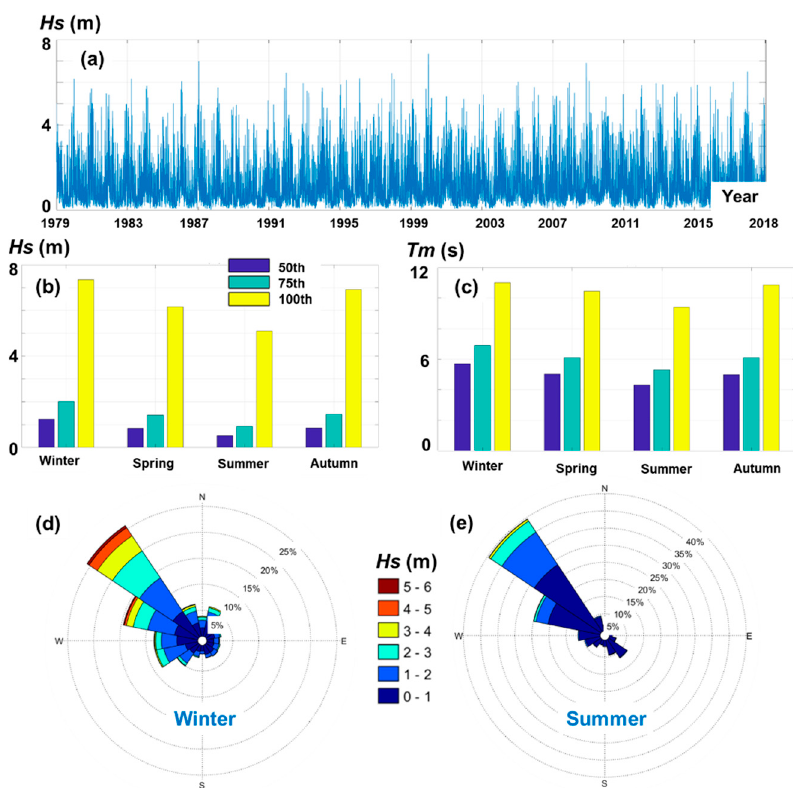
Figure 5. Wave conditions corresponding to the geographical position of the point O1, according to the ERA-interim data (January 1979 to December 2018). The results are indicated in terms of: ( a ) Hs time series; ( b ) and ( c ) 50, 75, and 100 percentiles of the parameters Hs and Tm , respectively, for each season; ( d ) and ( e ) wave roses computed for the winter and summer seasons, respectively. Table 2. Statistics of the wave conditions near the site O1 according to the 40-years of European